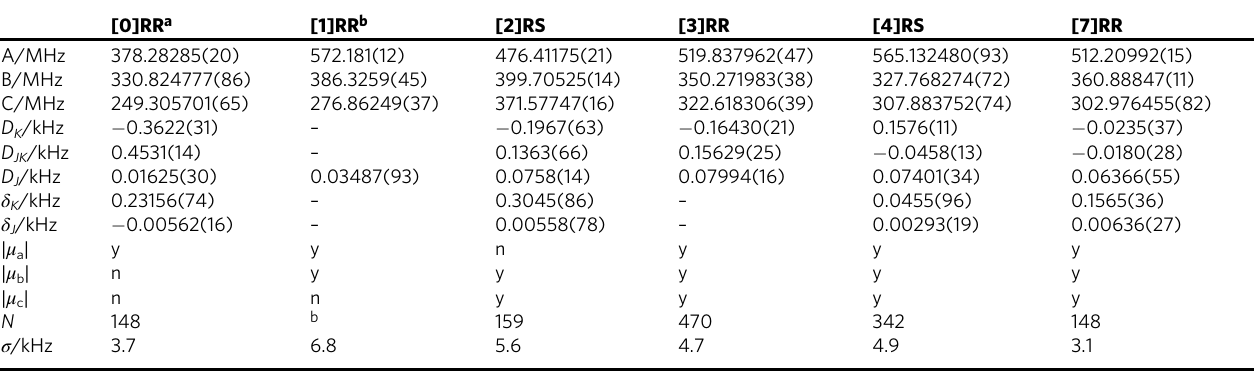
Fig. 2 Rotational spectra of SO in the 2 – 8 GHz range. a Fourier transform broadband microwave spectrum obtained after co-adding and averaging 4M FIDs (15h of measurement time). b Full frequency range vertical zoom highlighting relevant spectral portions. c – f Experimental spectral portions (upper traces, in black) and simulations (lower traces) obtained from the fi tted spectroscopic parameters for dimers [2]RS ( c red), [4]RS ( d blue), [3]RR ( e green) and [7]RR ( f yellow). Table 2 Observed spectroscopic parameters for homochiral and heterochiral dimers of styrene